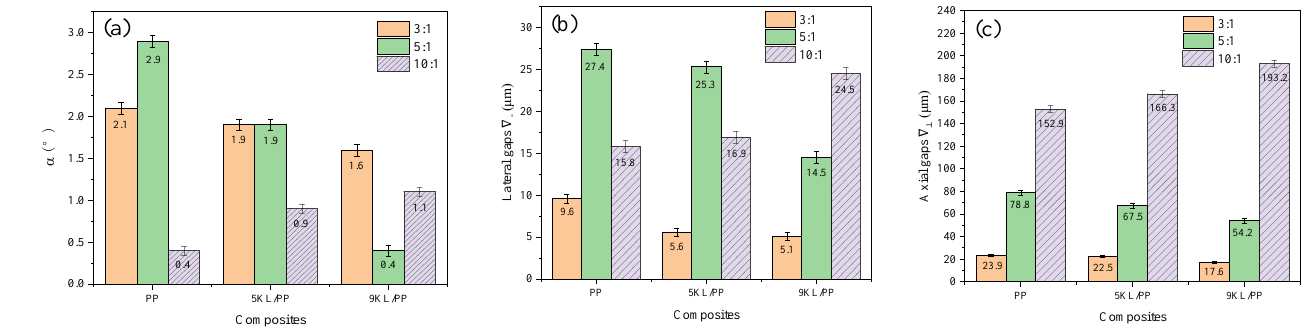
Figure 13. Effect of different aspect ratios and different composites on ( a ) the angle α , ( b ) the lateral gaps ∇ − , and ( c ) the axial gaps ∇ ⊥ .